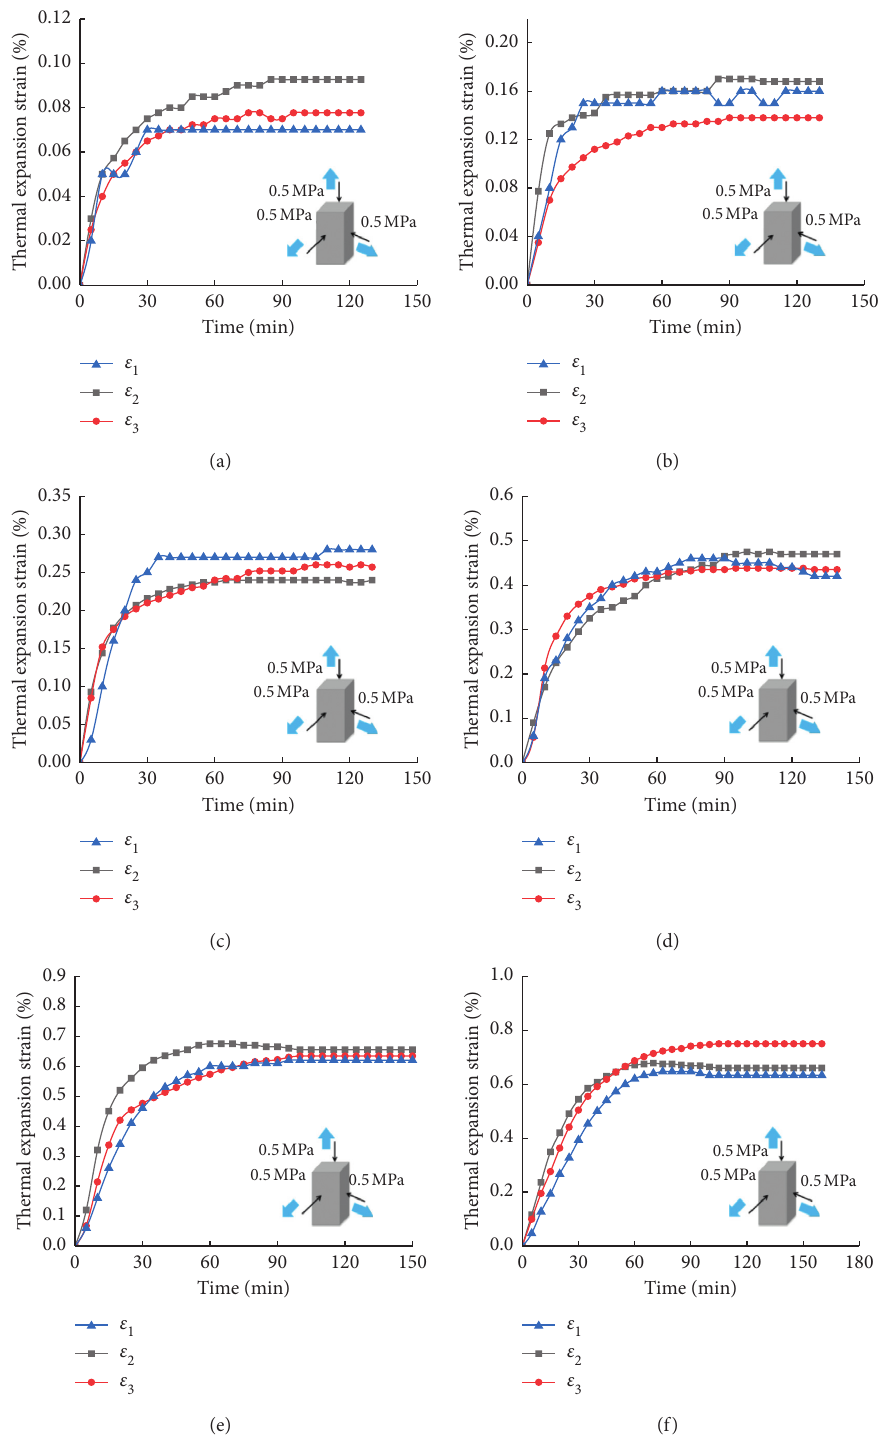
Figure 4: Thermal expansion strains of concrete under three-dimensional stress condition. (a) 100 ° C, (b) 200 ° C, (c) 300 ° C, (d) 400 ° C, (e) 500 ° C, and (f) 600 °